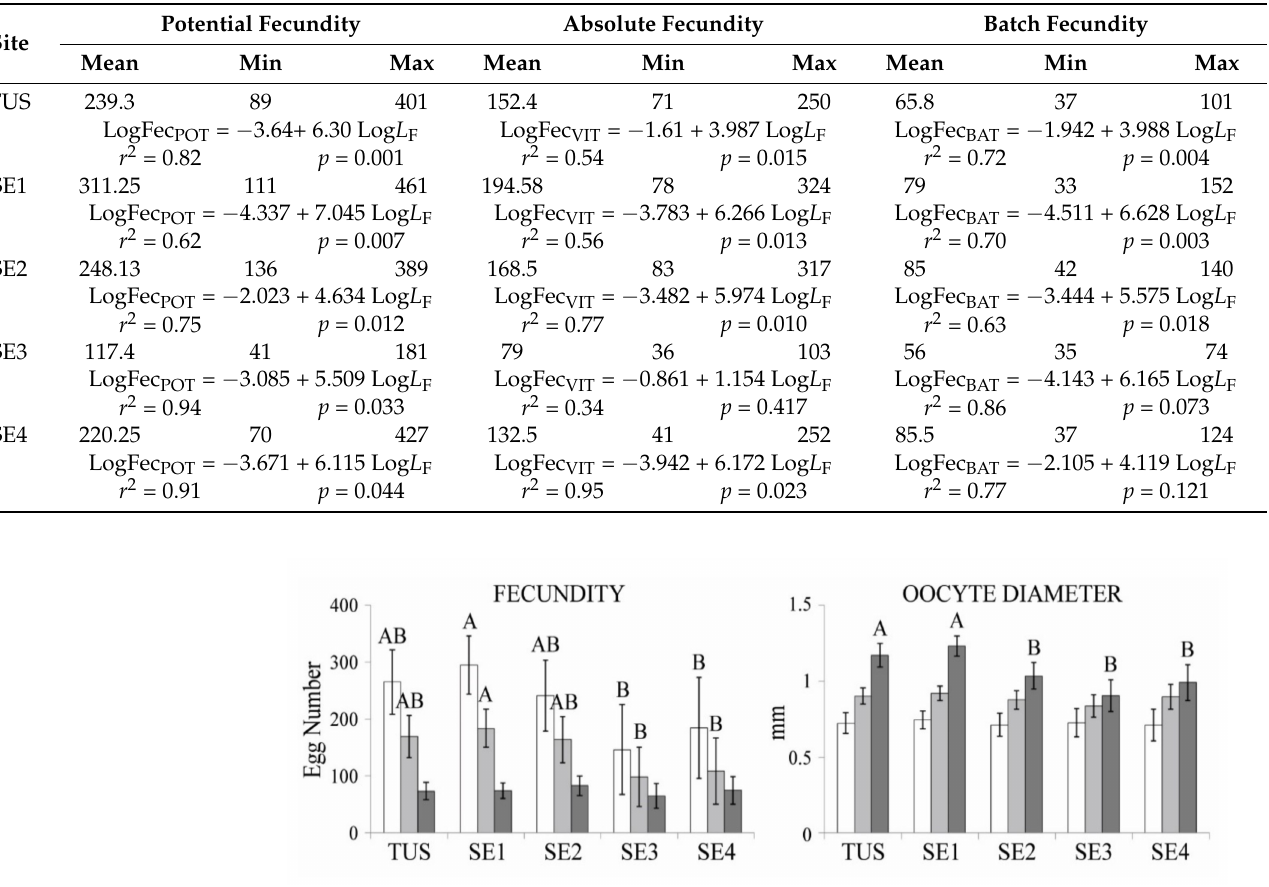
Figure 5. Estimated marginal means (by ANCOVA) ± IC 95% at 9.0 cm of fork length for oocyte number and diameter of opaque plus vitelogenic oocytes (potential fecundity; white bars), and of vitelogenic oocytes (absolute fecundity; grey bars) and oocytes of batch fecundity (dark grey bars). Letters show significant differences (ANCOVA, Bonferroni post hoc tests) among sampling